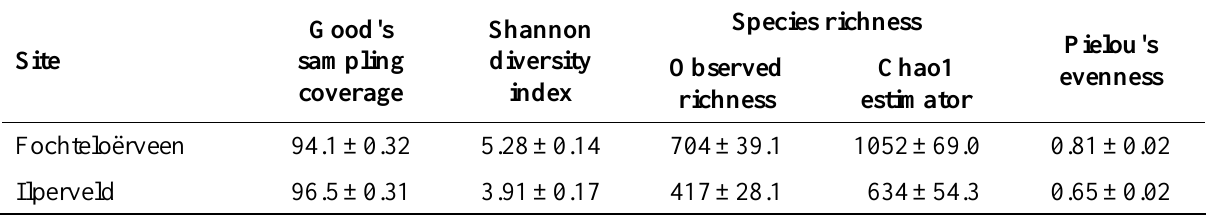
Table A5. Alpha diversity indices by site.